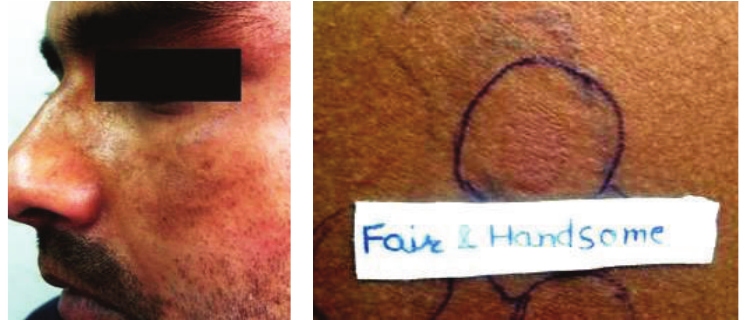
Figure 2: Irritant patch test (Janus type) reaction from Fair & Handsome cream in a male with malar pattern.